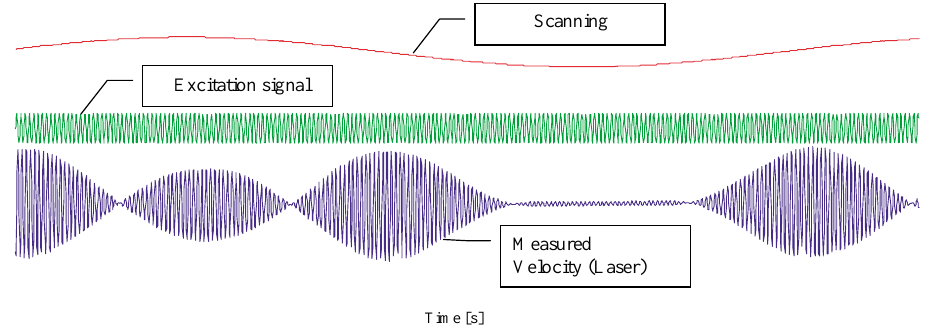
Fig. 4. A typical frequency response function of the vibrating plate.